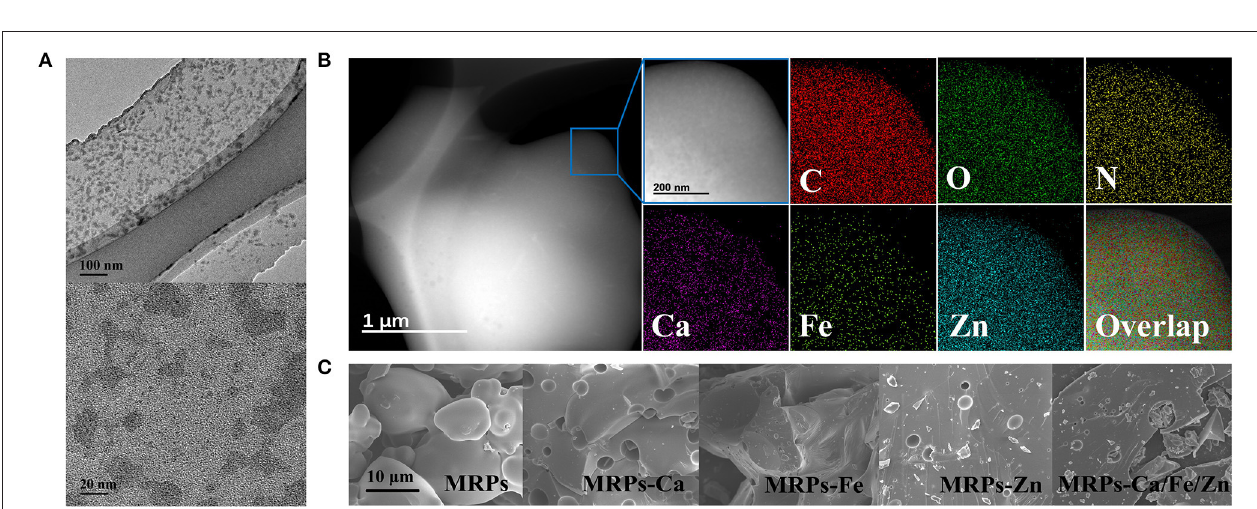
FIGURE 2 | Transmission electron microscopy (TEM) images of MRPs–Ca/Fe/Zn (A) . STEM images and corresponding elemental mapping analysis of MRPs–Ca/Fe/Zn (B) . Scanning electron microscopy (SEM) images of MRPs, MRPs–Ca, MRPs–Fe, MRPs–Zn, and MRPs–Ca/Fe/Zn (C) .